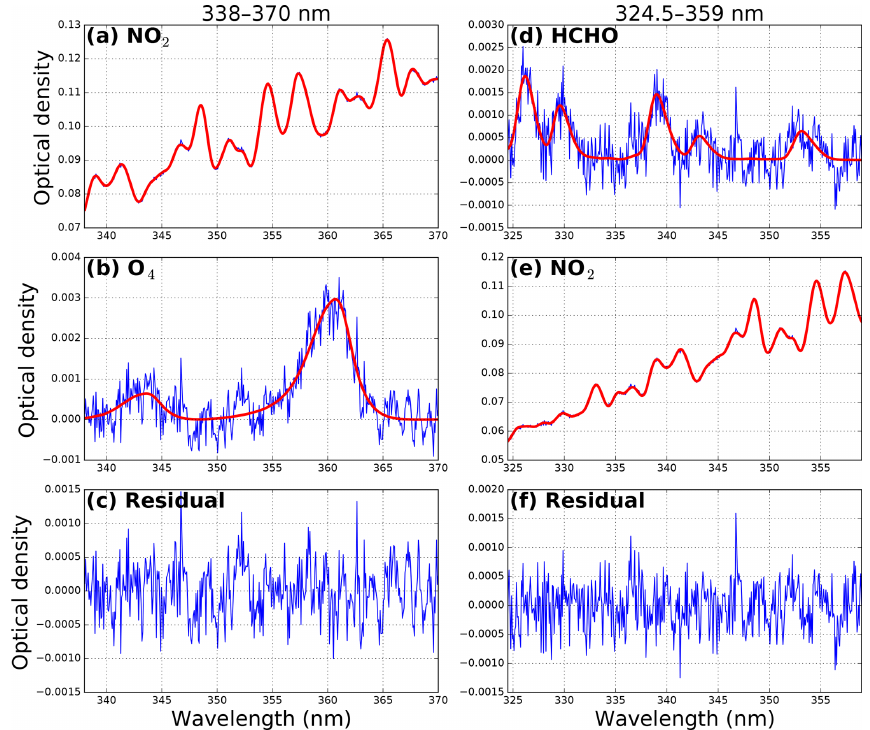
Figure 1. An example of the DOAS retrieval of NO 2 and HCHO DSCDs from a MAX-DOAS spectrum taken on 12 May 2013 at 08:48LT (local time) with viewing elevation angle of 1 ◦ . Panels (a, b, c) show the DOAS fit in the wavelength range of 338–370nm, while panels (d, e, f) show DOAS fit in the wavelength range of 324.5–359nm. Table 1. The DOAS retrieval settings for different wavelength bands. Species Temperature Wavelength